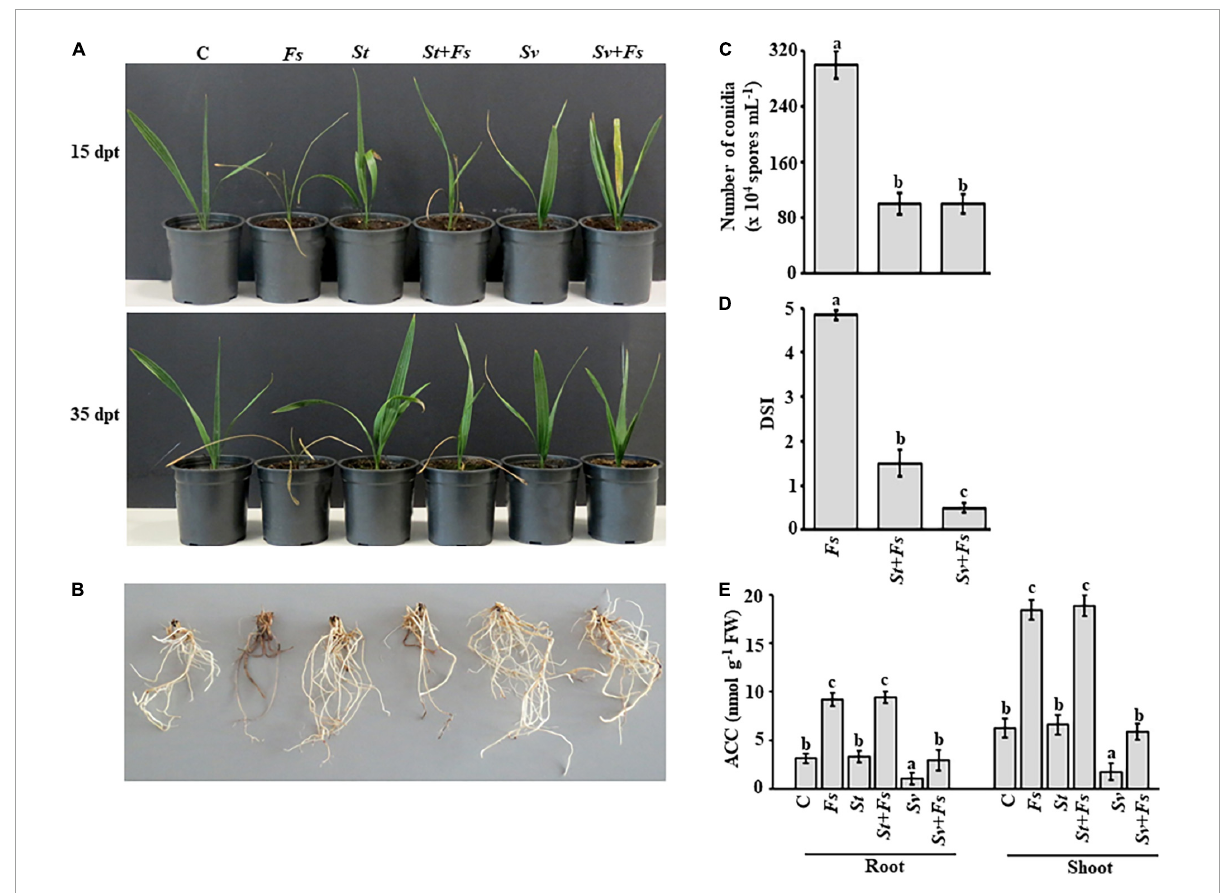
FIGURE3 Effect of BCA treatments on date palm seedlings in soils infested with Fusarium solani . Preventive effect of BCA treatments on (A) seedlings and (B) roots in soil not-infested or infested with F. solani after 15 (upper panel) and 35 dpt (lower panel). Recovery of seedlings ( n = 16) from pathogen infection was measured according to (C) the number of conidia; (D) DSI, (E) endogenous contents of ACC in the root and shoot tissues of inoculated date palm seedlings after BCA treatment after 35 dpt under greenhouse conditions. In (D) , DSI was based on a scale of 5:0 = no infection, 1 = 1–10, 2 = 11–25, 3 = 26–50, 4 = 51–75, and 5 = 76–100% damage including necrosis, white area in leaves or rotting in roots. In (C–E) , values with different letters are significantly different from each other at P < 0.05. Bars represent standard errors. C, seedlings grown in non-pathogen colonized soil (control); Fs , seedlings grown in soil infested with F. solani (diseased control); St or Sv , seedlings grown in soil colonized with either the non-ACCD-producing Streptomyces tendae UAE1 (BCA1; isolate #6) or the ACCD-producing Streptomyces violaceoruber UAE1 (BCA2; isolate #26), respectively; St + Fs or Sv + Fs , seedlings grown in soil colonized with either S. tendae UAE1 or S. violaceoruber UAE1, respectively, 7 days prior to incorporation of F. solani -millet seed based inoculum; ACC, 1-aminocyclopropane-1-carboxylic acid; ACCD, ACC deaminase; BCA, biological control agent; FW, fresh weight; dpt, days post treatment; DSI, disease severity